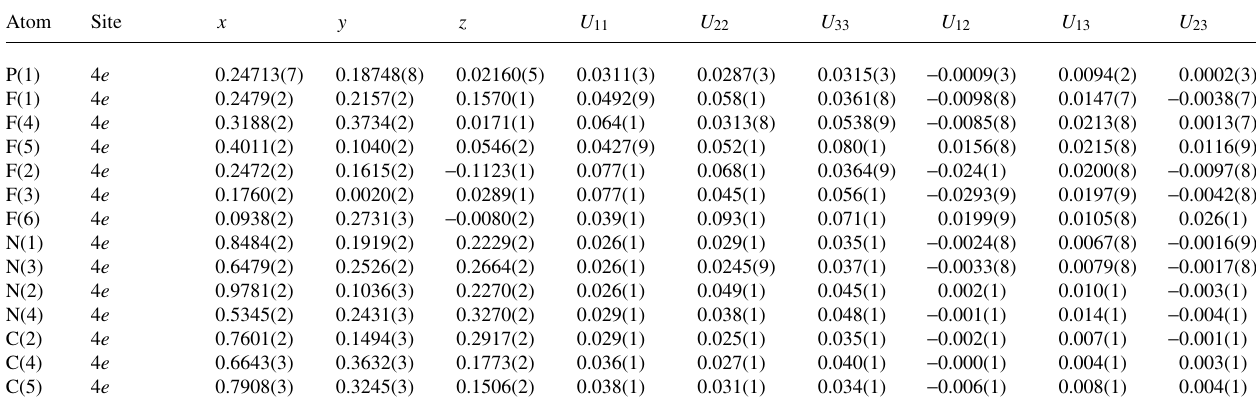
Table 3. Atomic coordinates and displacement parameters (in Å 2 )